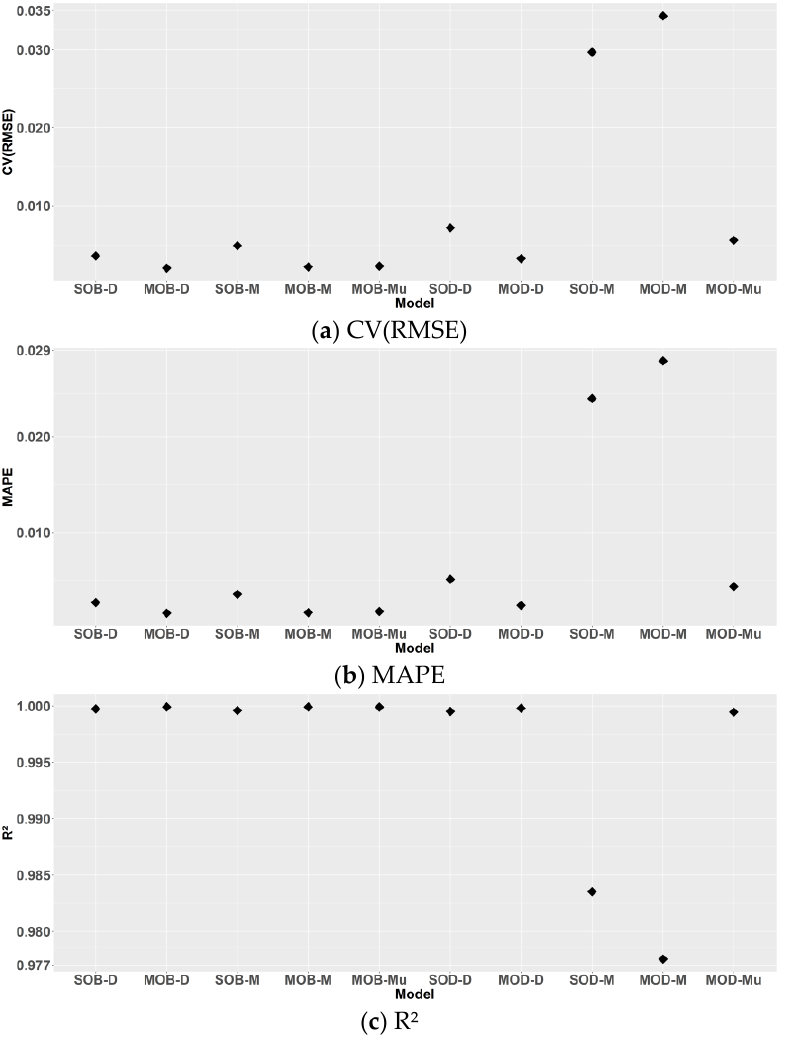
Figure 20. Performance of 10 models for annual heating energy (refer to Table 4 for model explana- tion).